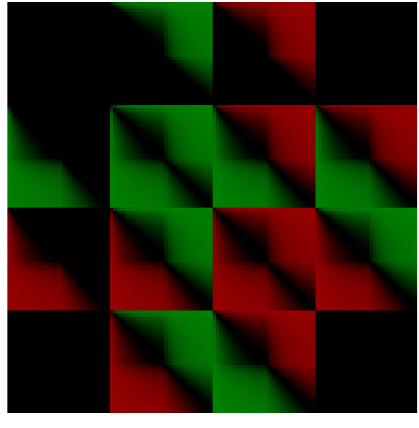
Figure 5. Area texture.